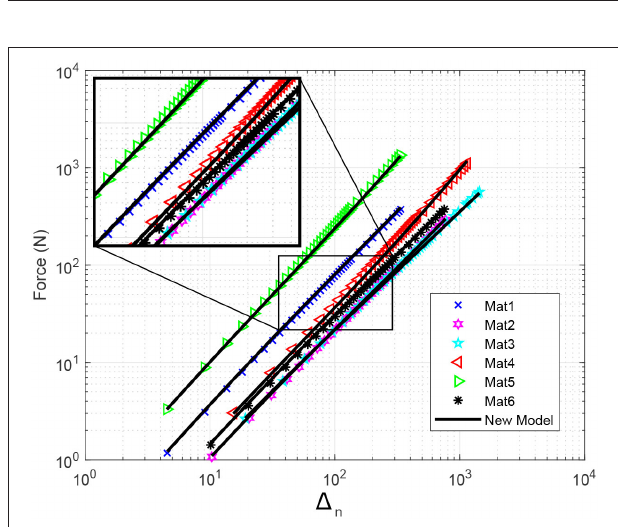
FIGURE 13 | Comparison between all materials for contact force in loglog scale. The markers show the FEM results and the continuous lines show the